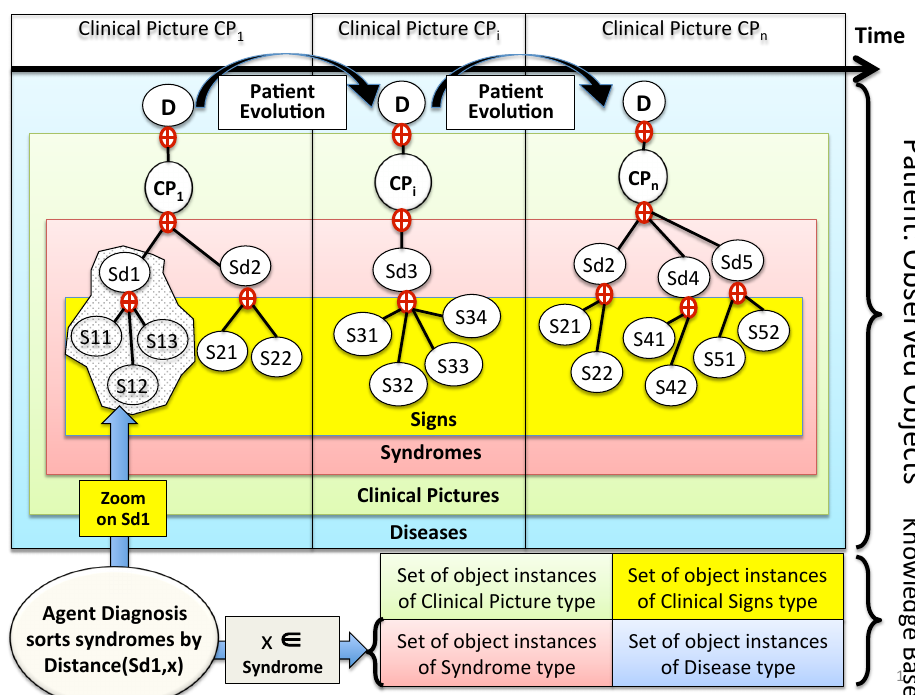
Figure 16. Clinical picture evolution object-oriented